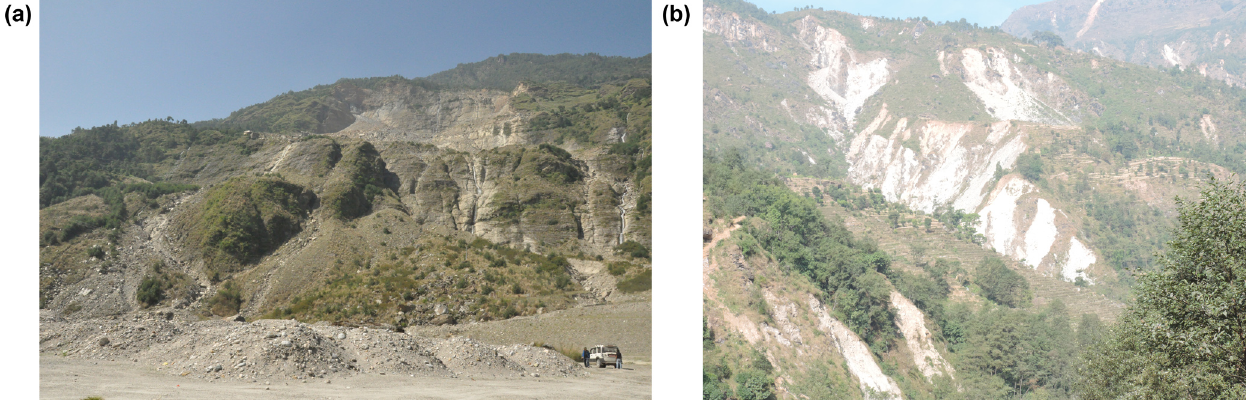
Figure 2. Field investigation on landslide in the Koshi River basin. (a) Jure landslide triggered by rainfall which occurred on 2 August 2014 at the Sunkoshi river (photo by Bintao Liu in 2017). (b) Small-size landslides triggered by the Gorkha earthquake in the Bhote Koshi